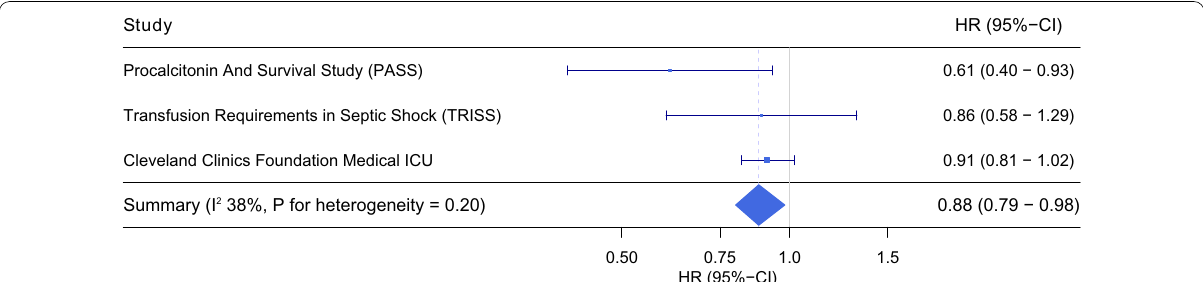
a All cohorts adjusted for age, sex, ischemic heart disease, previous stroke and whether the patient had a pulmonary infection focus. The analyses are stratified for recruiting